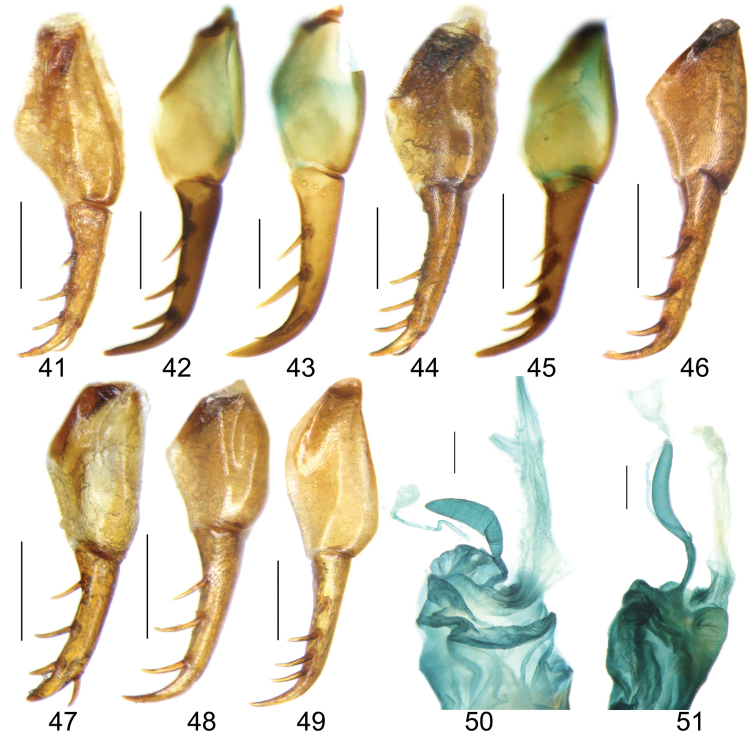
41–49 Stylomere of right ovipositor, ventral view, 41
P.
gibbosus sp. n., Xizang (Mêdog) 42
P.
elegans sp. n., Xizang (Mêdog) 43
P.
dux Andrewes, Yunnan (Jinghong) 44
P.
obscuratus sp. n., Guizhou (Fanjingshan) 45
P.
acutidens sp. n., Yunnan (Longchuan) 46
P.
ornatus
formosanus Dupuis, Taiwan (Miaoli) 47
P.
amplus Andrewes, Myanmar (Putao) 48
P.
ornatus
ornatus Schmidt-Göbel, Hainan (Baisha) 49
P.
obtusipennis Fedorenko, Yunnan (Longling) 50–51 Female reproductive system 50
P.
obtusipennis Fedorenko, Yunnan (Longling) 51
P.
ornatus
ornatus Schmidt-Göbel, Yunnan (Mengla). Scale bars: 0.2 mm.